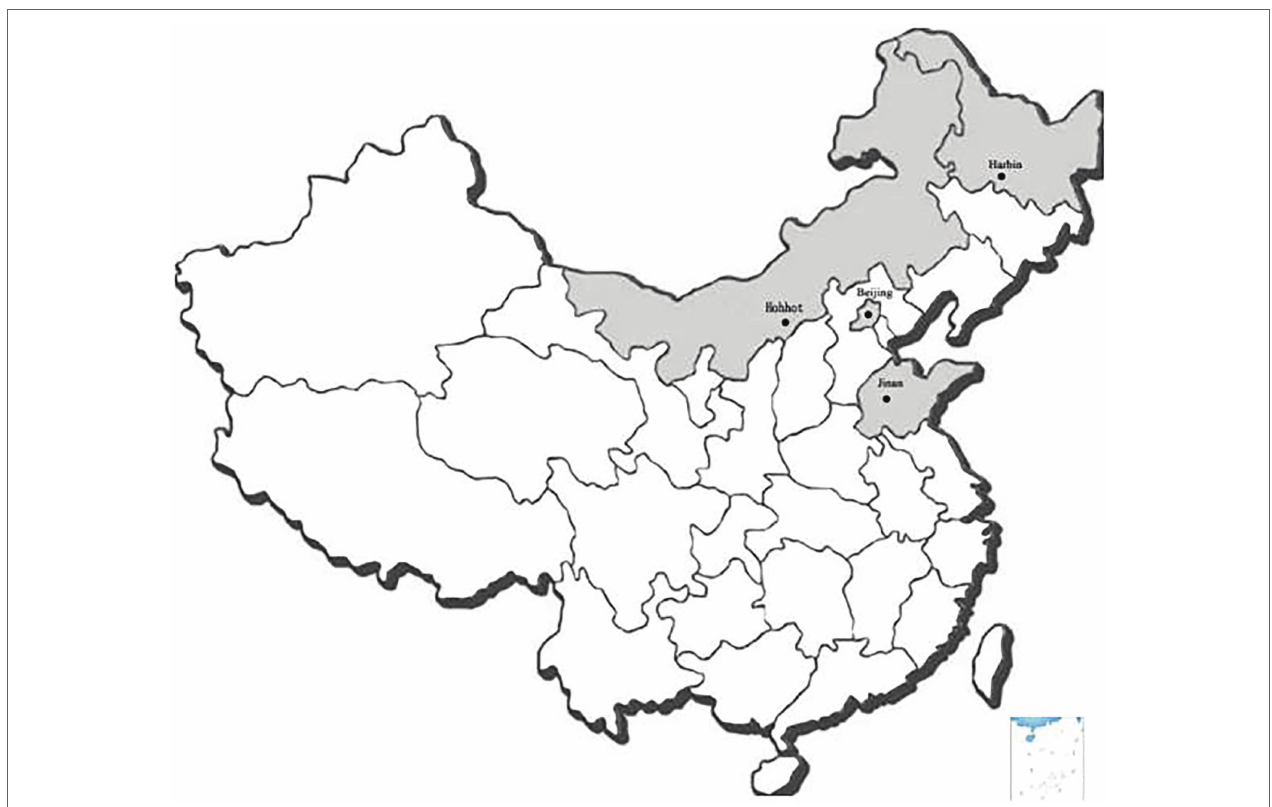
FIGURE 1 | Map of sampling locations. In total, 195 samples were collected from Hohhot, Beijing, Harbin, and